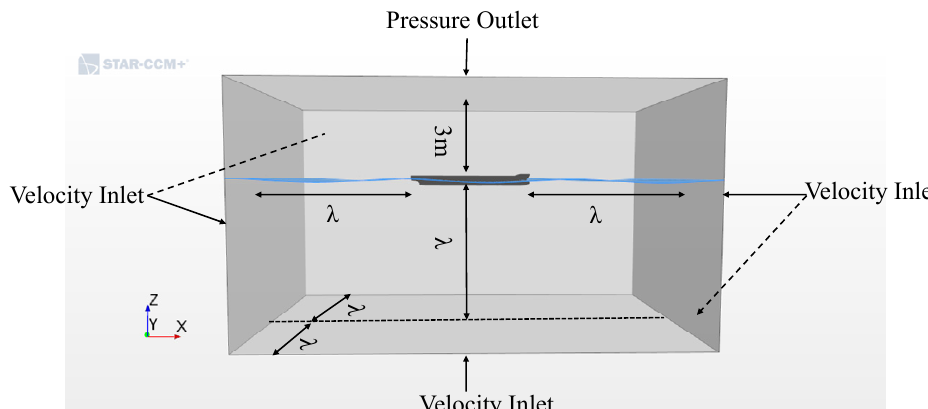
Figure 2. Calculating domain size and Boundary Conditions setting.